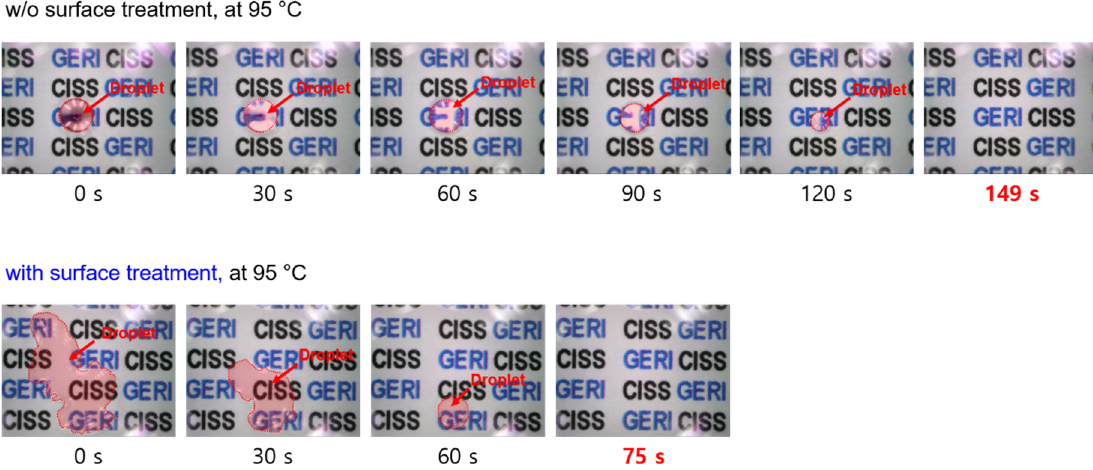
Figure 7. Microscopic images of DI water droplet evaporation on heater surfaces (heat-generation temperature of 95 ° C).